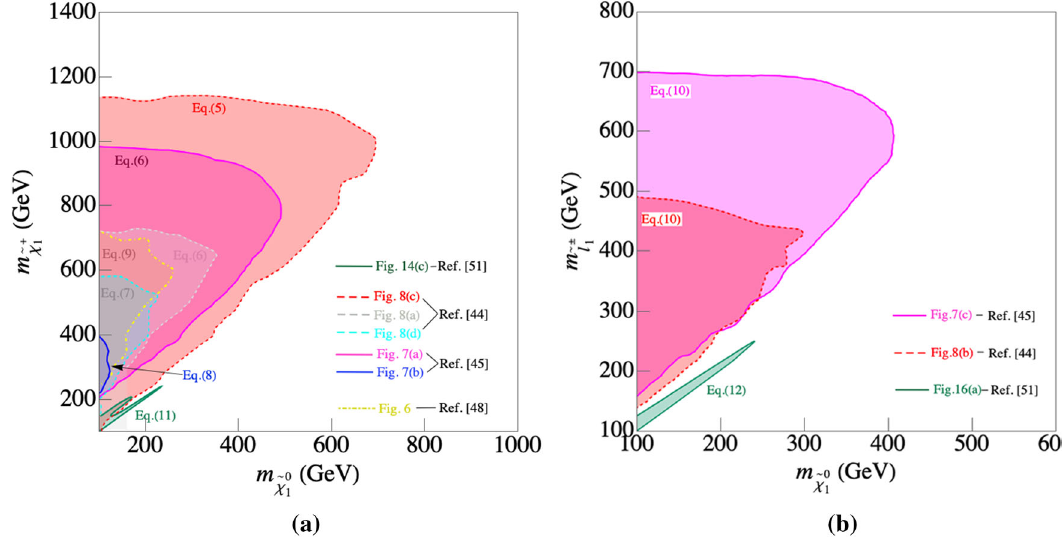
- m ˜ χ ± (left) and m ˜ χ 0 1 1